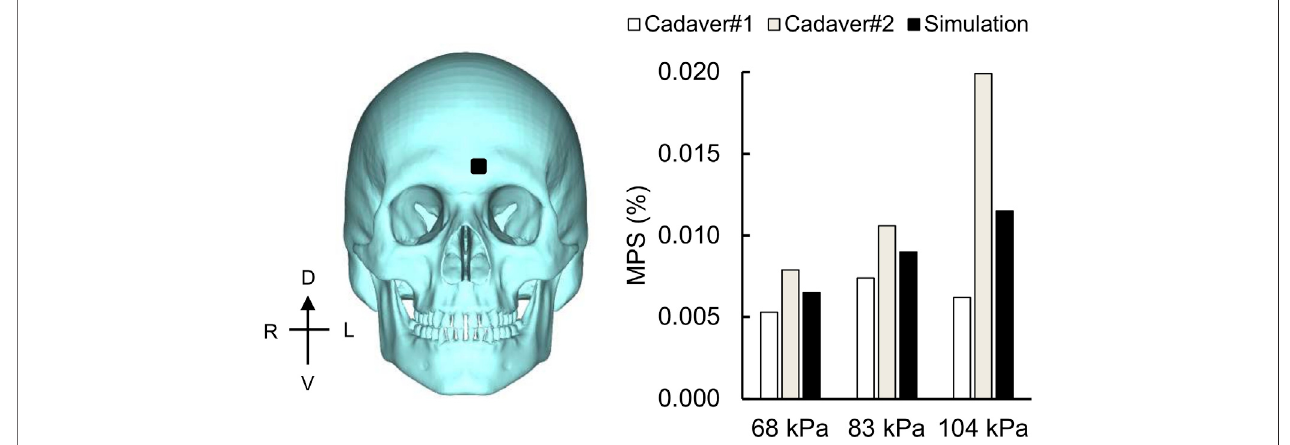
FIGURE 10 | Simulation showing the maximum principal strain (MPS) on the skull. Bar graph comparing the simulated and experimentally measured peak MPS values on the frontal bone (black square) for the 68, 83, and 104 kPa blast overpressures. D: dorsal; V: ventral; R: right; L: